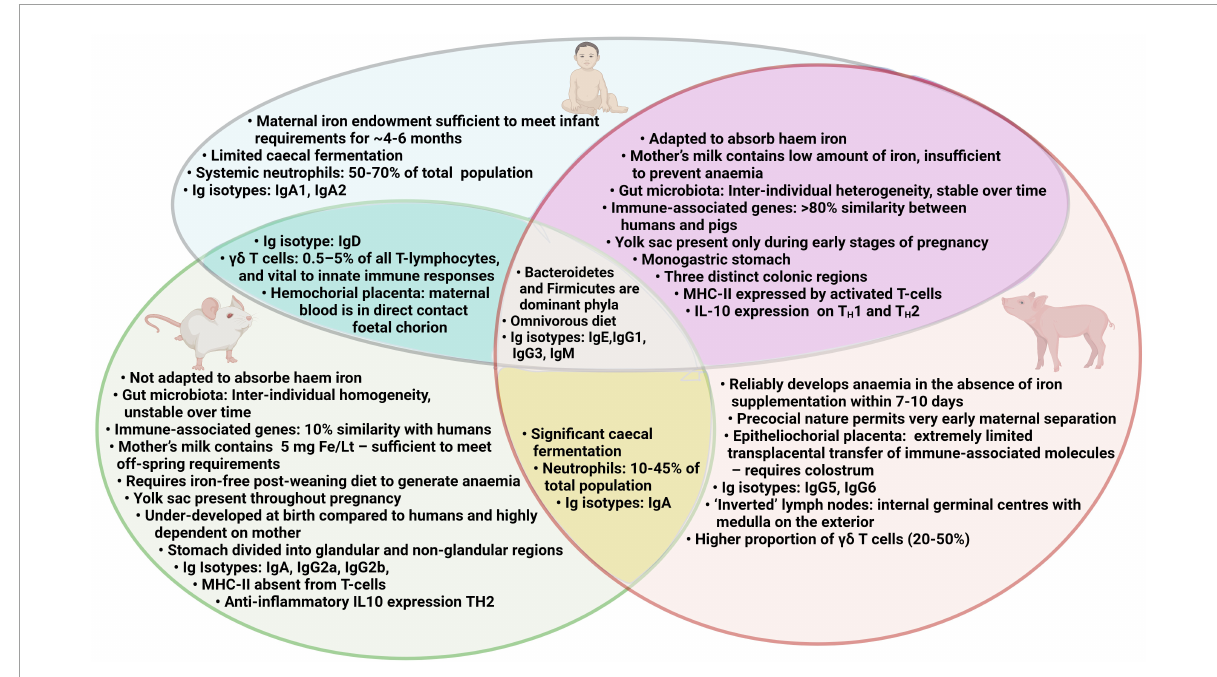
FIGURE2 Comparison of human, pig and mouse characteristics relevant to assessing the effect of iron deficiency anemia and iron